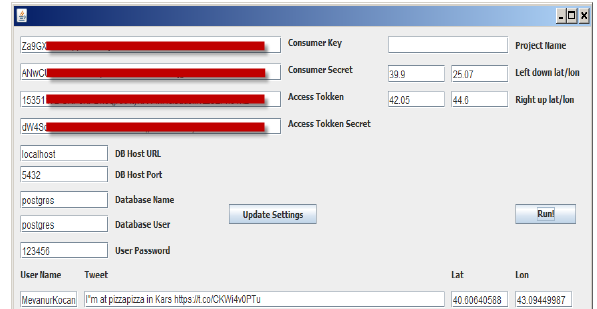
Figure 1. User interface of the Geo Tweets Downloader